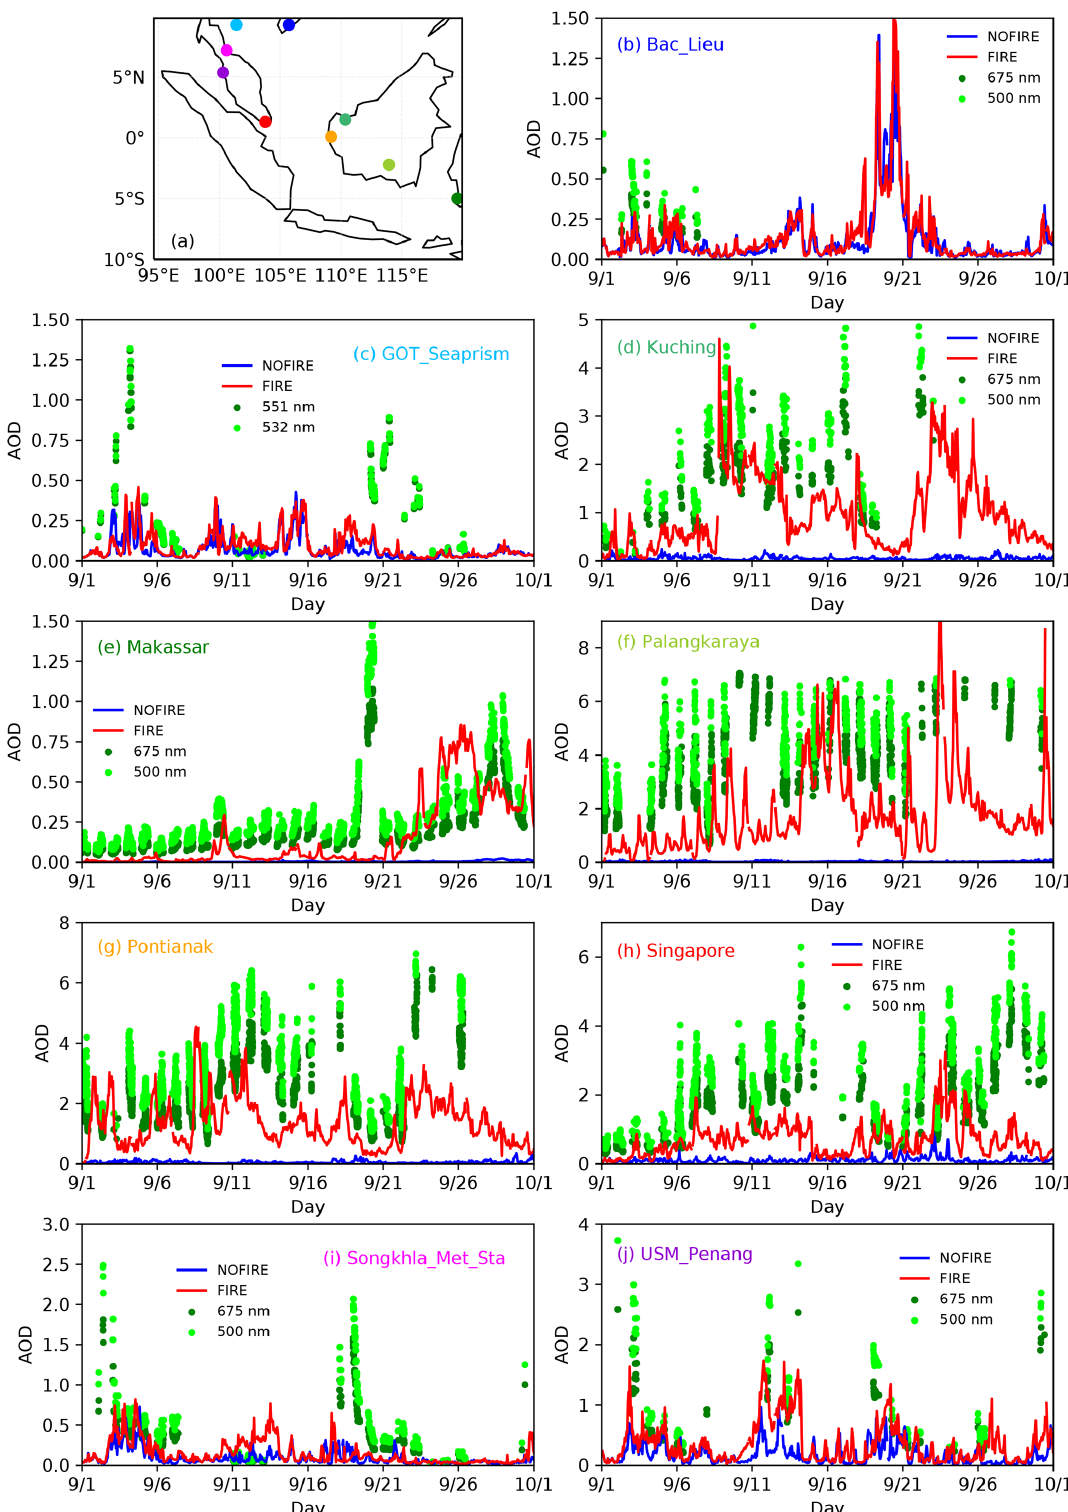
Figure 7. (a) Locations of nine AERONET stations whose AOD data for the month of September 2015 are shown in (b) – (j) in green (675nm) and lime (500nm). For (c) , they are AODs at 551nm (green) and 532nm (lime) instead. Red and blue lines are estimated AODs at 550nm from the FIRE and NOFIRE simulations,